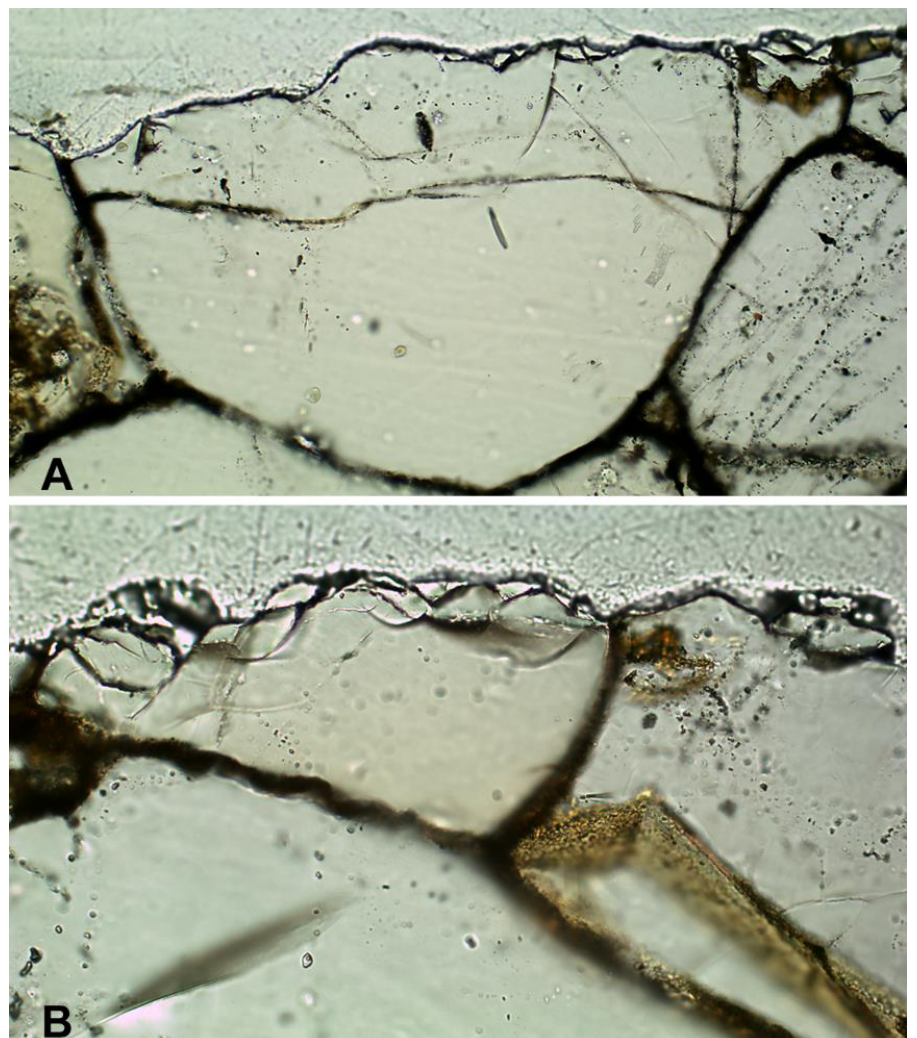
Figure 5. (A) This section of quartz grain truncated by the fluvial bombardment of the bedrock surface. (B) Another example of the battering evident at the tectonite